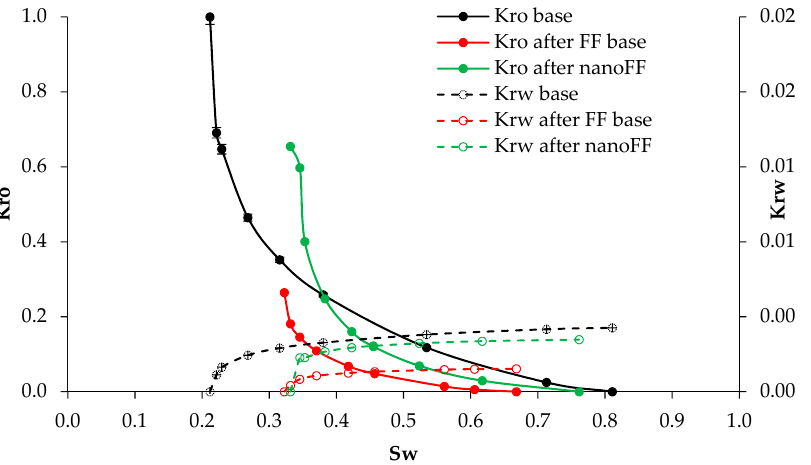
Figure 12. Relative permeability curves before and after injection of the original and optimized NanoFF were conducted in the proppant porous media.